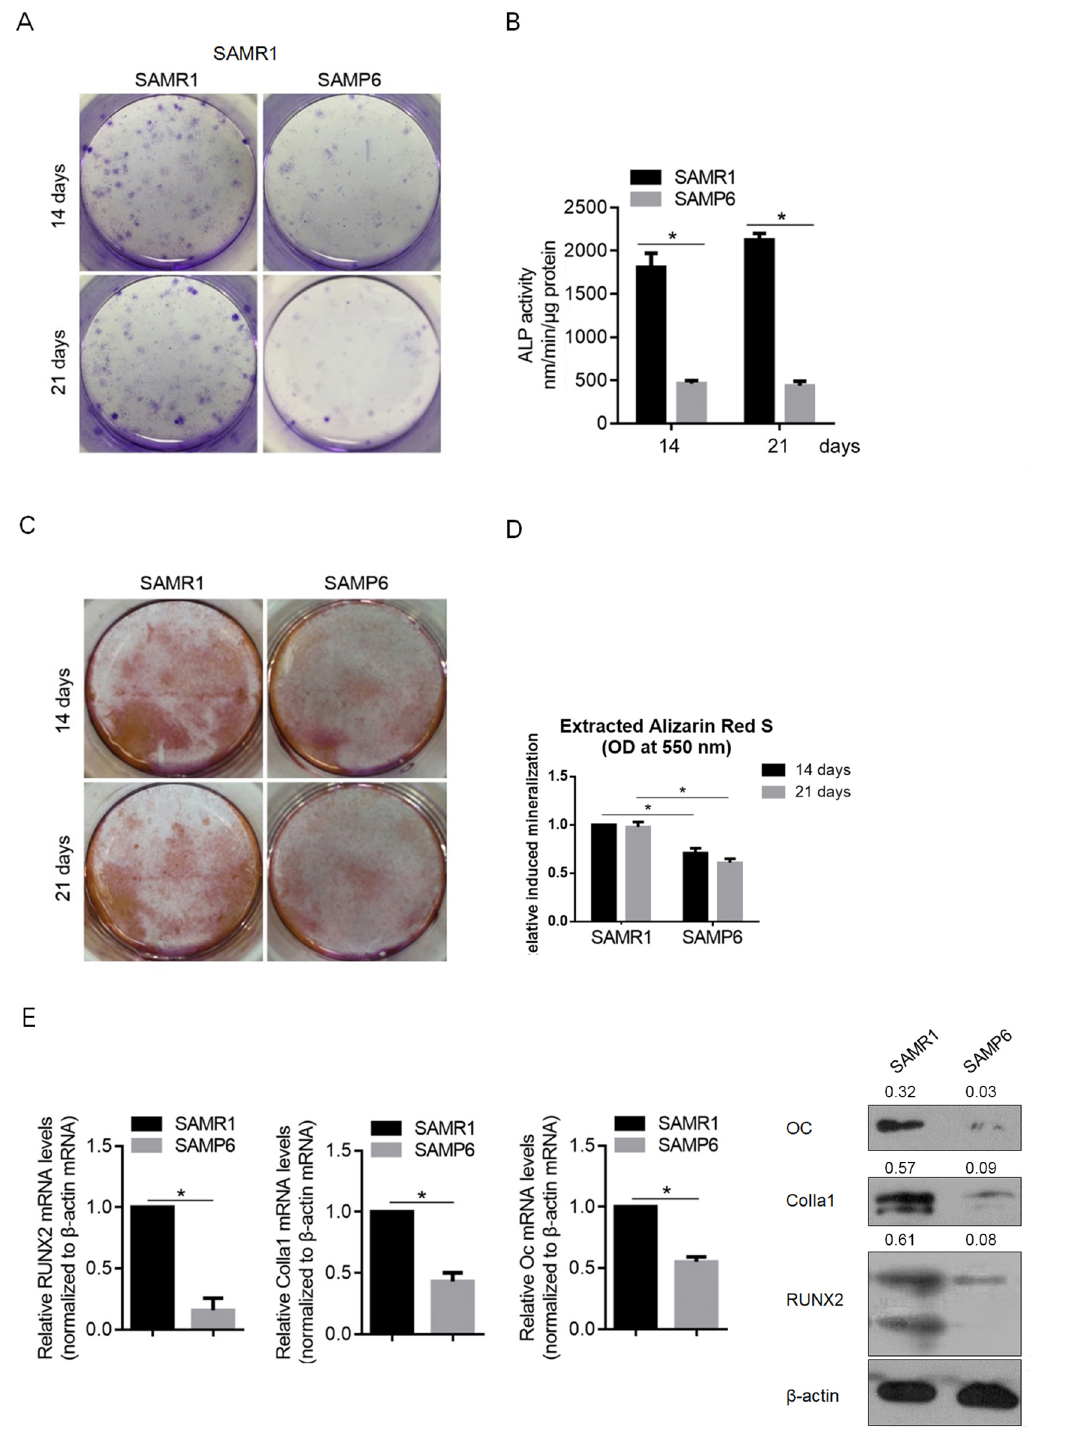
Fig 2. SAMP6 osteoblasts exhibit decreased maturation and mineralization in the presence of BMP-2 compared with SAMR1 osteoblasts. To evaluate the effects of BMP-2 on the maturation and mineralization of SAMP6 or SAMR1 osteoblasts, after 14- and 21-day exposure to BMP-2, the expression levels of ALP (A), ALP activity (B), Alizarin red S staining (C&D) and expression levels of Runx2, Colla and Oc (E) were measured. (cid:3) P < 0.05 vs. SAMR1.